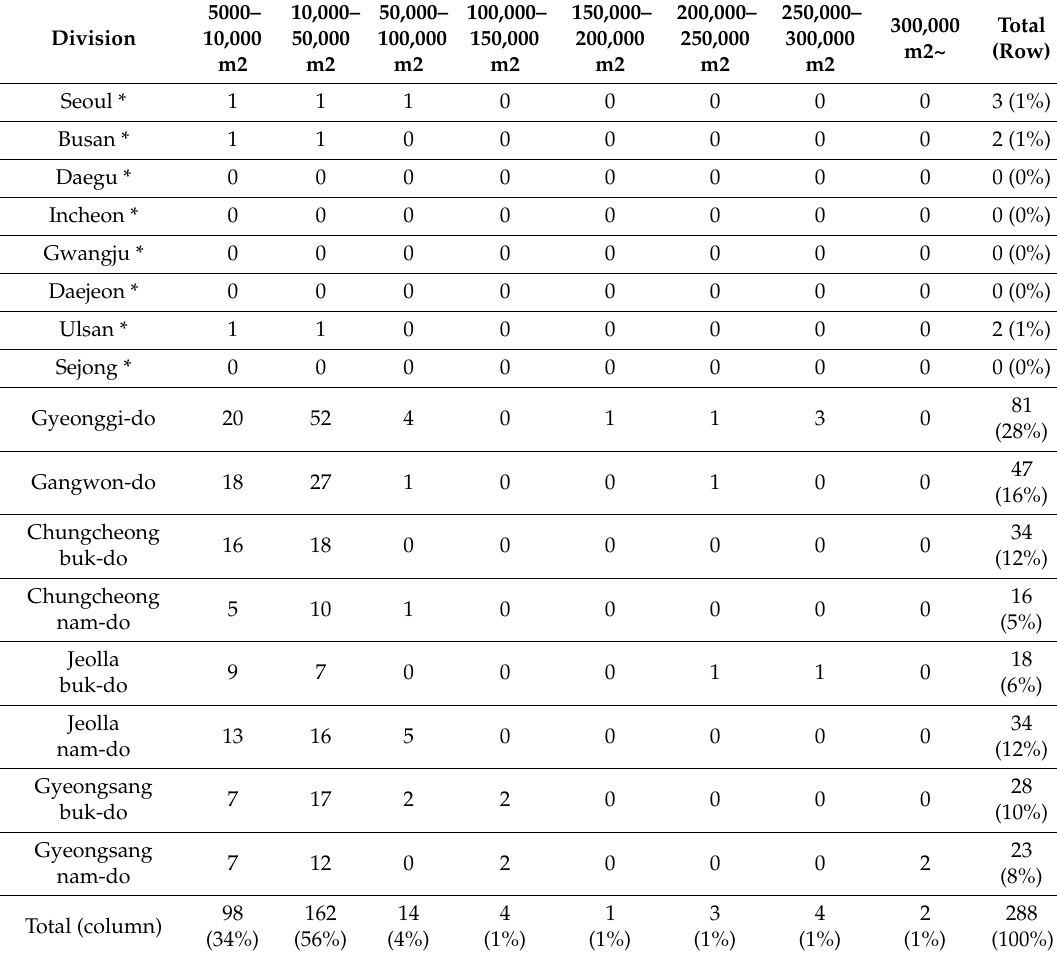
Table 5. Distribution status of damaged areas in South Korea derived through field surveys.